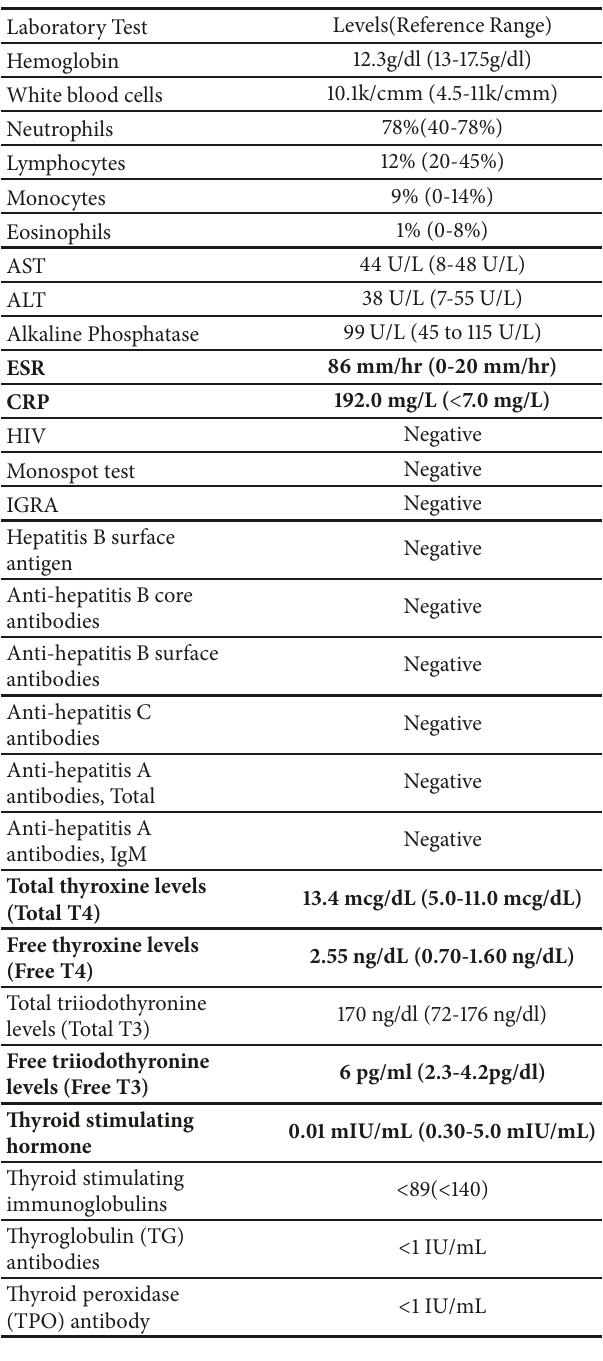
Table 1: Laboratory